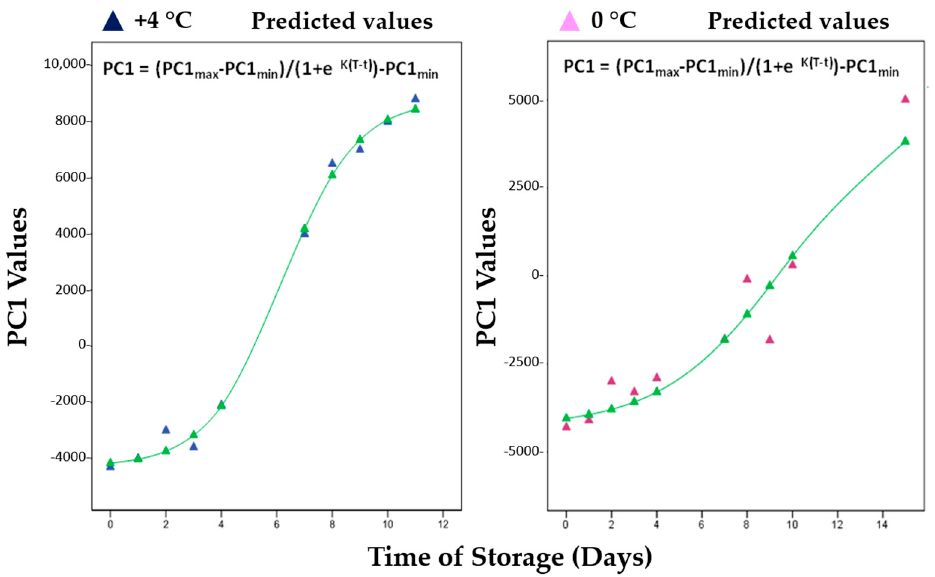
Figure 7. Fitted exponential and logistic models of PC1 values for red mullets ( Mullus barbatus ) during the storage at both +4 °C and 0 °C.